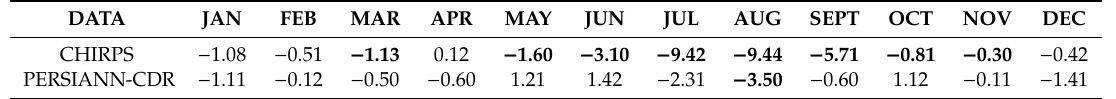
Table 8. Monthly rainfall trend of gridded datasets (mm / decade,